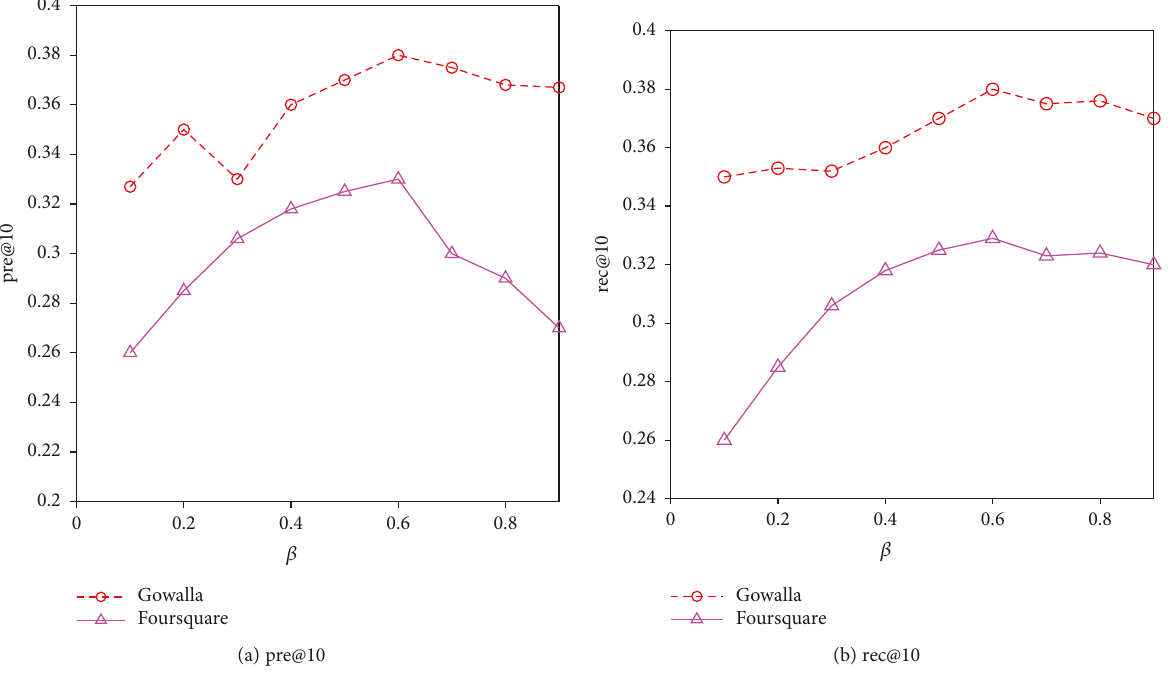
Figure 2: Impact of parameter β